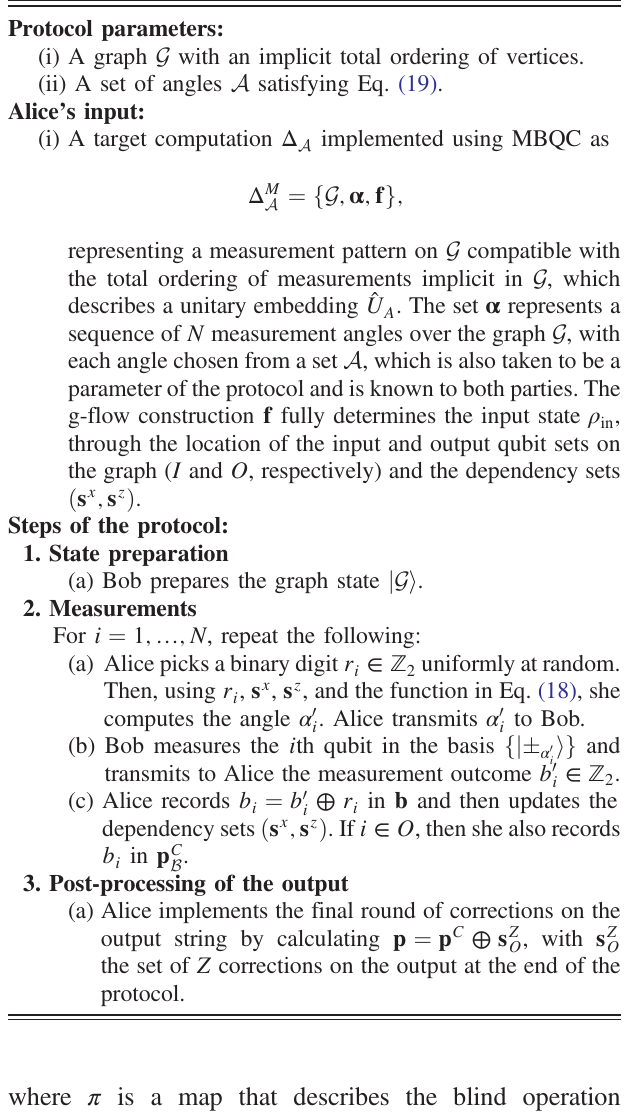
Protocol 1 CDBQC ð G ; A Þ : Classically Driven Blind Quantum